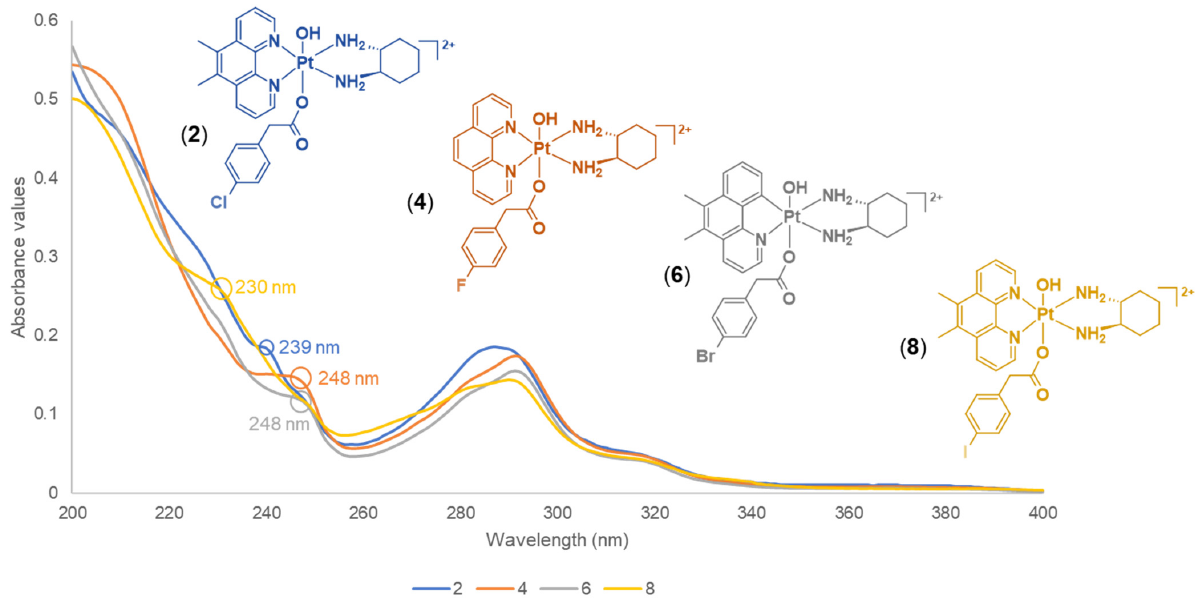
Figure 14. Stacked UV spectra of 5,6-Me 2 phen derivatives, 2 , 4 , 6 and 8 obtained at 298 K, showing UV absorptions at different wavelengths. Inset: colour-coded structures of 2 , 4 , 6 and 8 .